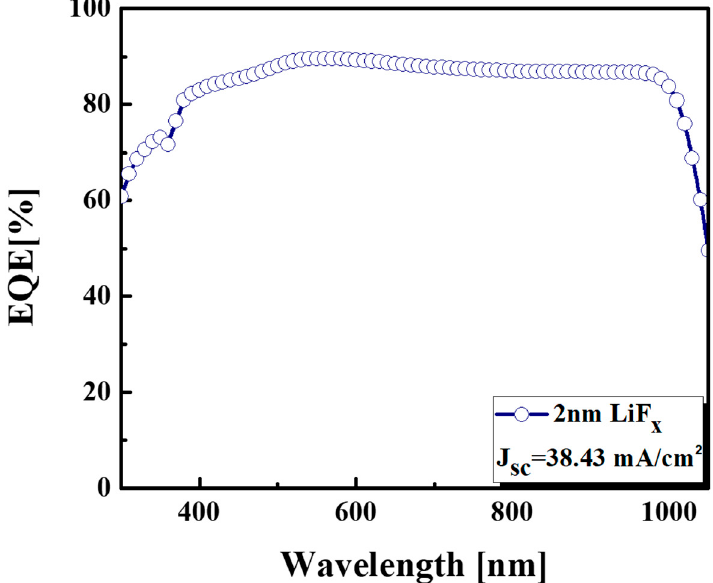
Figure 3. External quantum efficiency (EQE) of SHJ solar cells for a 2 nm thick LiF x as an electron carrier selective contact